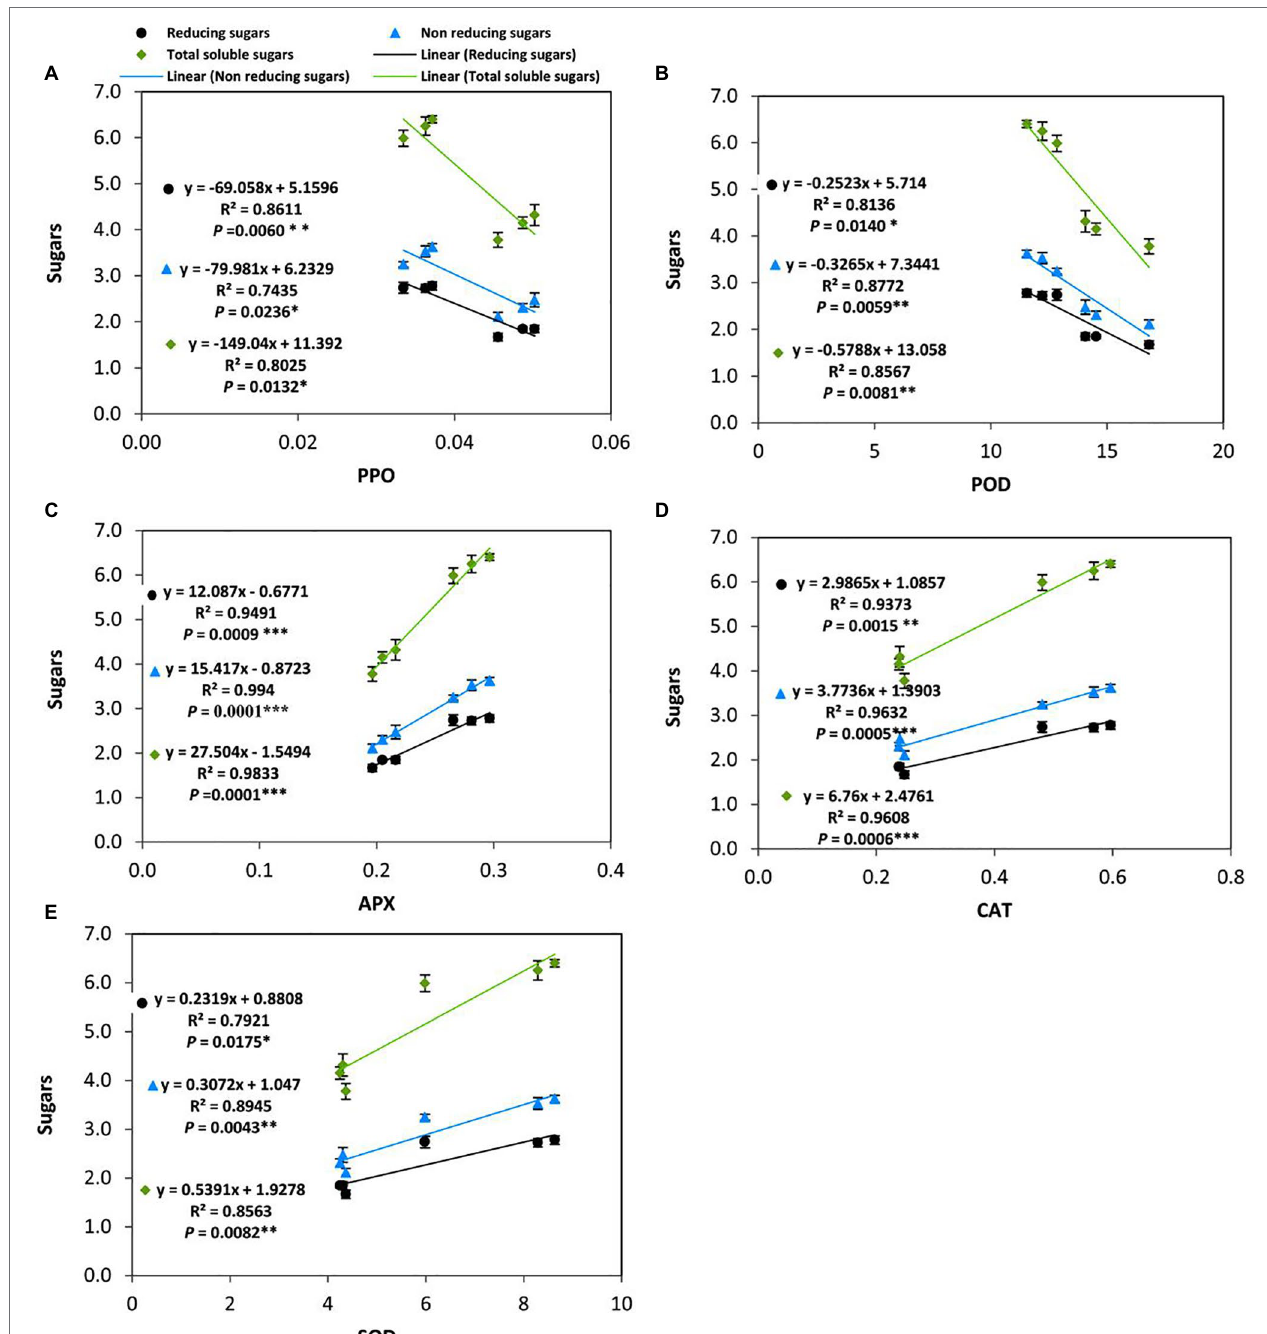
FIGURE 7 | Linear regression analysis elucidates the relationship between the soluble sugars, antioxidant enzyme activities, superoxide dismutase (SOD), catalase (CAT), polyphenol oxidase (PPO), and peroxidase (POD), ascorbate peroxidase (APX) in tomato plants cv “Super marmende” treated by γ -aminobutyric acid (GABA) as a foliar application at 1 and 2 mM and growing under normal (25°C/20°C day/night) and chilling conditions (5 days/4ºC for 6 h/day) followed by 2 days recovery. ns. non-significant; * P ≤ 0.05; ** P ≤ 0.01; and *** P ≤